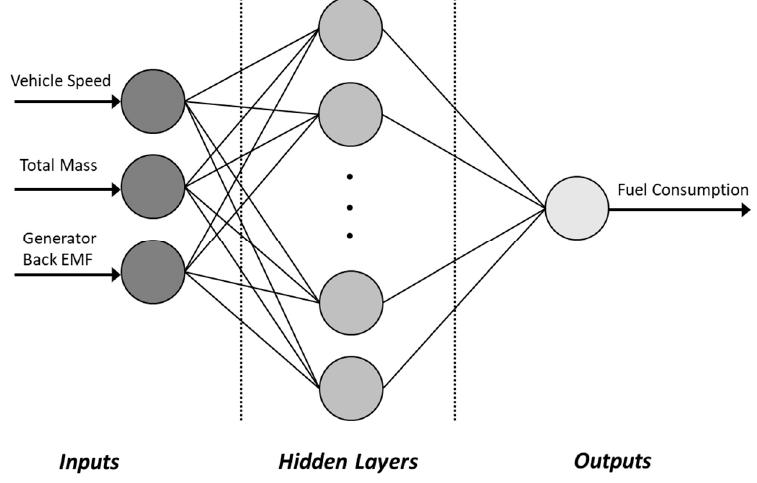
Figure 16. The architecture of artificial neural network (ANN).